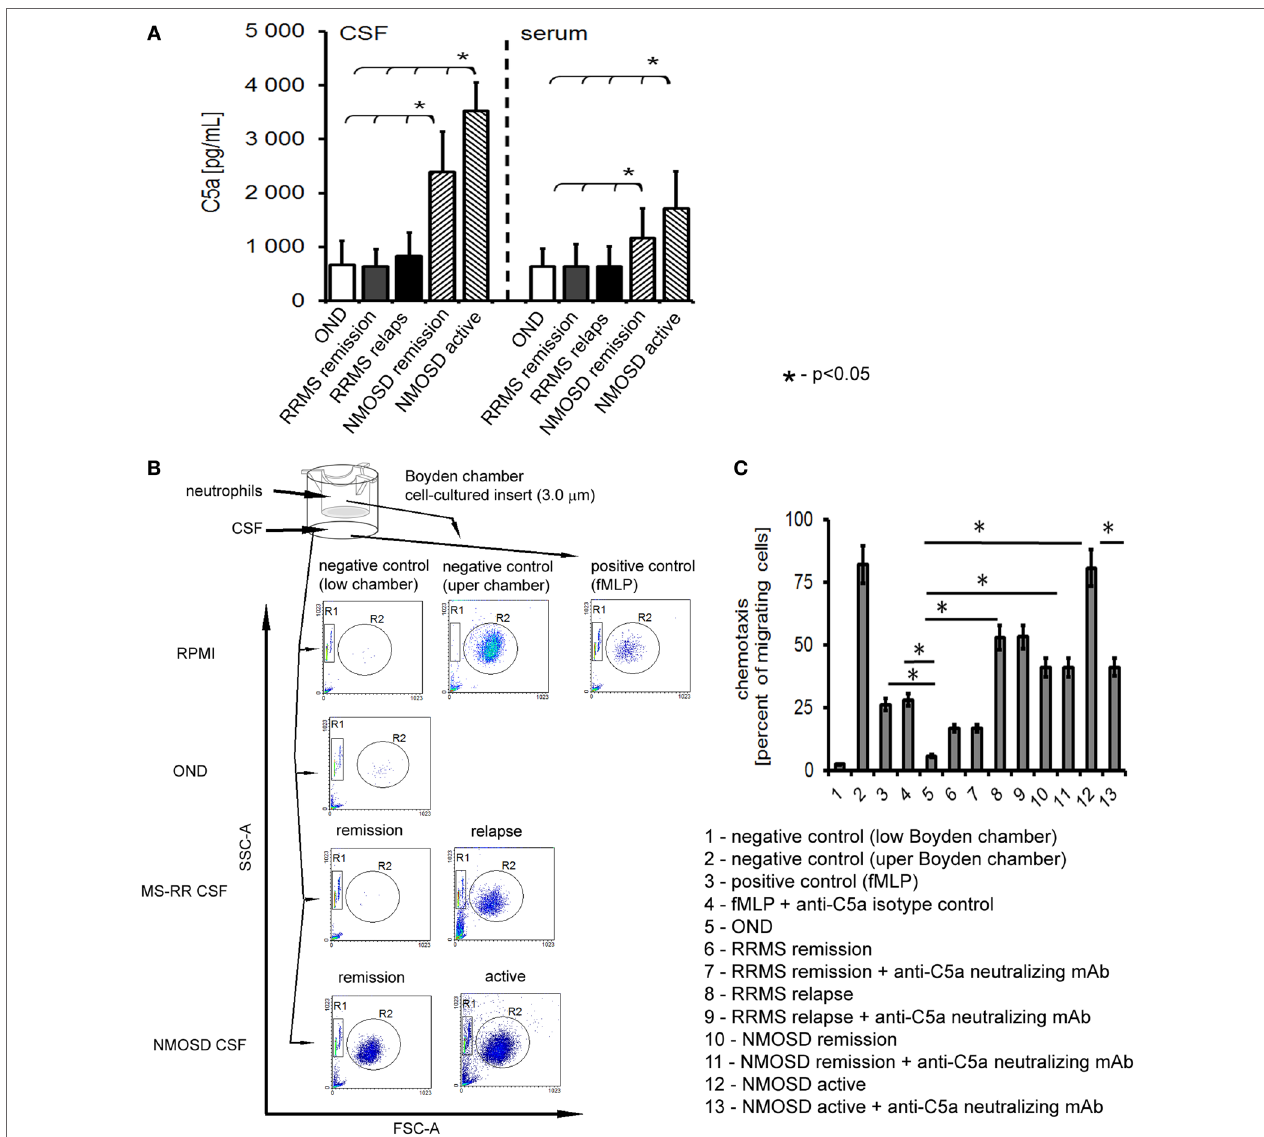
FigUre 1 | Cerebrospinal fluid (CSF) derived from neuromyelitis optica spectrum disorder (NMOSD) patients induces chemotaxis of healthy control neutrophils by C5a. (a) NMOSD is characterized by the high concentration of C5a in CSF and serum compared with remitting–relapsing multiple sclerosis (RRMS) or other neurological disorders (OND). The bars represent the means ± SD. (b) NMOSD CSF possesses chemotaxis properties independently of whether it was collected in the active or remission stage of the disease, while RRMS CSF possesses chemotaxis activity during disease relapse only. As a negative control, RPMI and neutrophils from upper chamber were used; as a positive control, fMLP was used. The example of one of four independent experiments. (c) NMOSD CSF chemotaxis properties are mainly dependent on the classical pathway of complement activation, as C5a neutralization inhibits neutrophil chemotaxis in NMOSD patients in oppose to RRMS CSF. Data are presented as the mean rates of cell migration ± SD from four independent